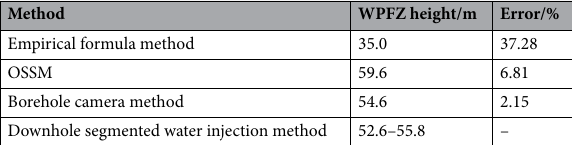
Table 3. Comparison of WPFZ height obtained by different